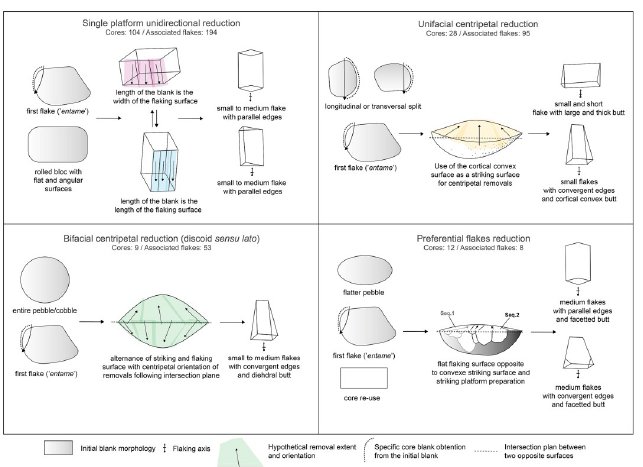
Fig 6. Sketches of the four main flake production strategies at Dungo IV and the techno-morphological patterns of the resulting flakes.